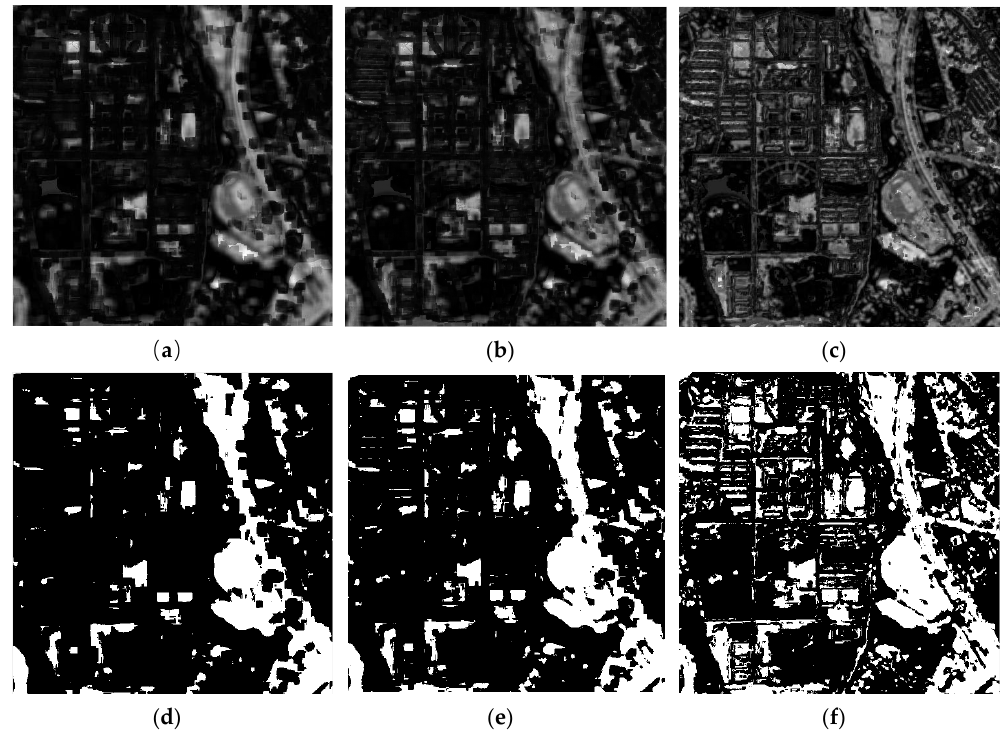
Figure 9. The results of change magnitude images and the binary change maps for data set 1. ( a ) change magnitude image ( n = 3). ( b ) change magnitude image ( n = 9). ( c ) change magnitude image ( n = 15). ( d ) binary change map ( n = 3). ( e ) binary change map ( n = 9). ( f ) binary change map ( n = 15).